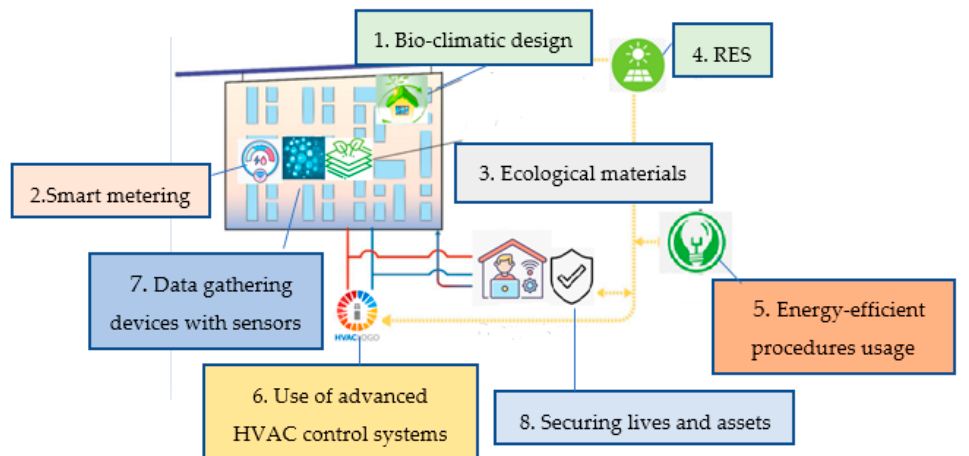
Figure 8. Influential factors in the smartness assessment framework of public buildings.